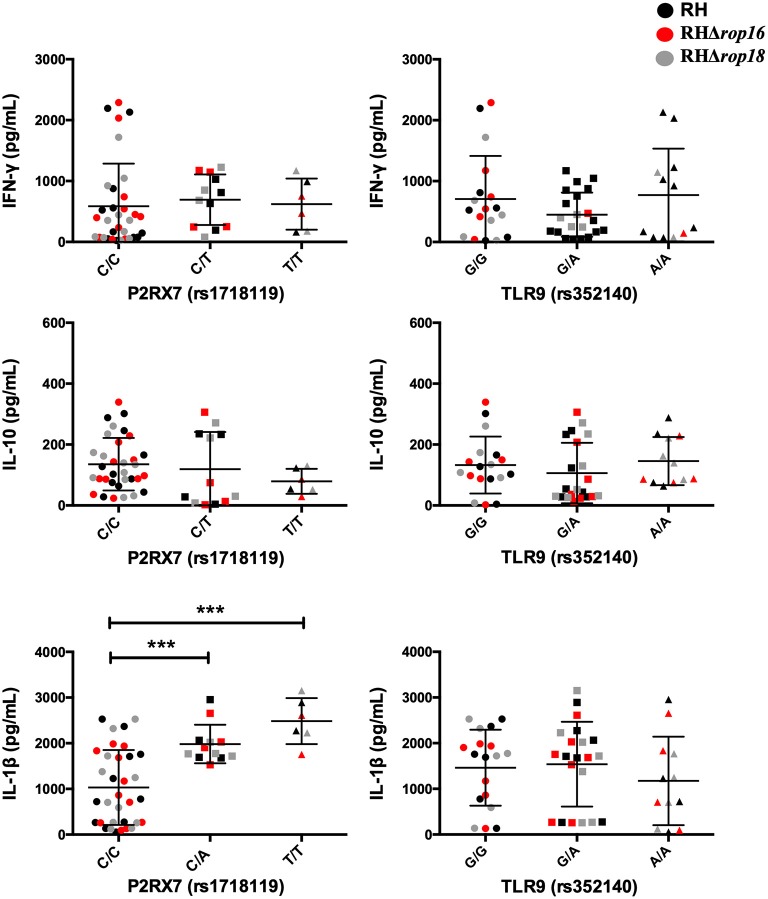
Cytokine production by PBMCs at 24 h post-infection with T. gondii RH (Black), RHΔrop16 (red), and RHΔrop18 (gray) was stratified by genotype of the following SNPs: P2RX7 (rs1718119) and TLR9 (rs352140). The levels of cytokines were measured by ELISA. Results are represented by circles or square for individual data and bars are the mean ± SD; ***p < 0.001. Mann-Whitney U test was performed.